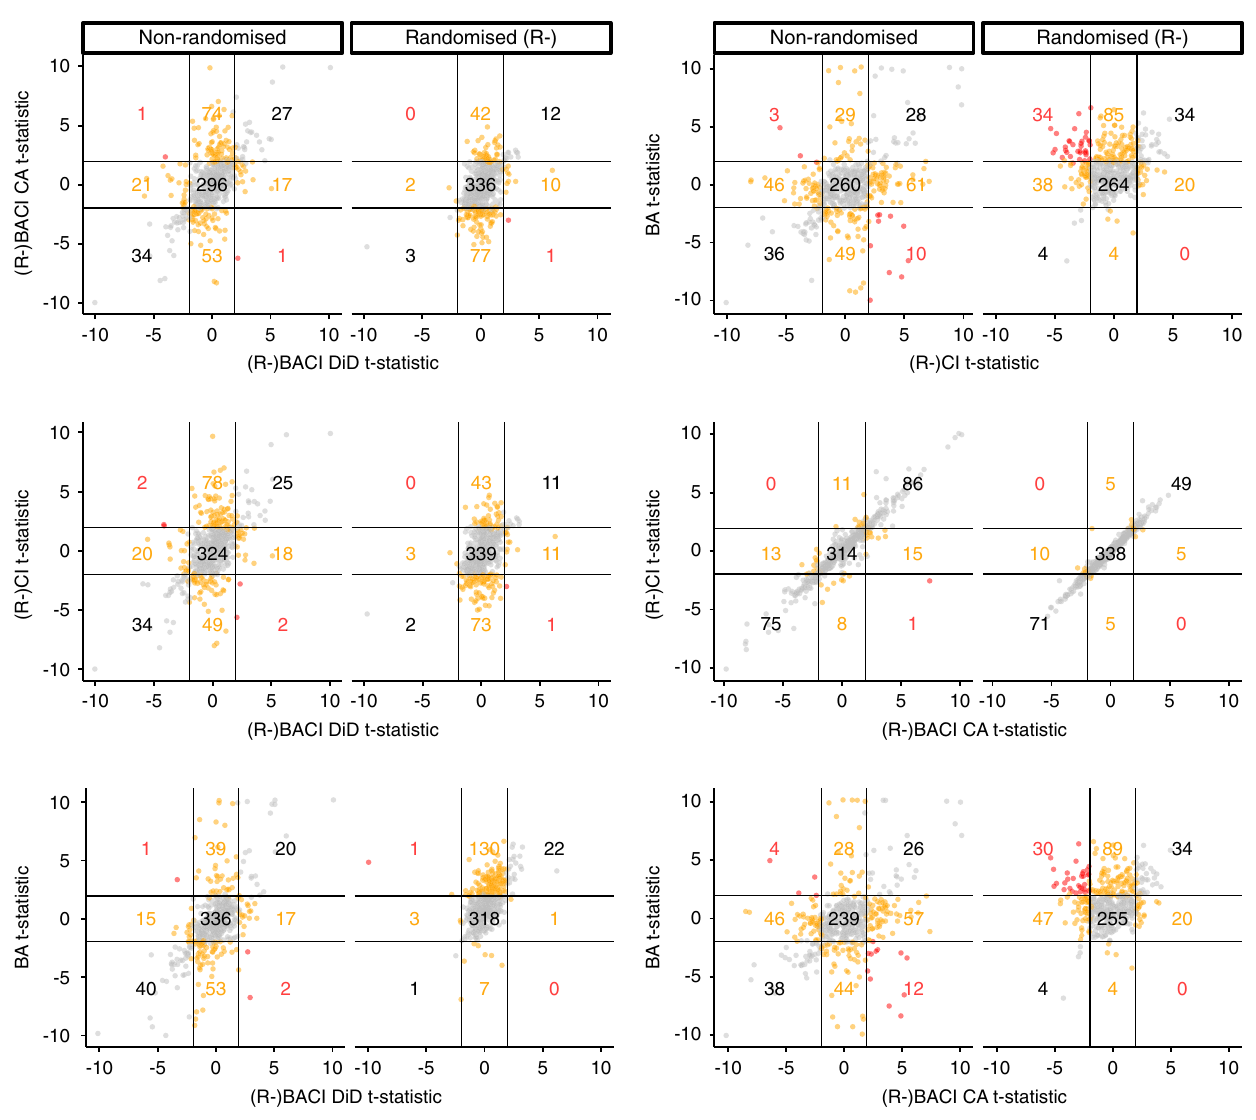
Fig. 3 Pairwise comparisons of t-statistics for estimates obtained using different study designs for responses across 49 different datasets (non- randomised or randomised). t-statistics were obtained from two-sided t-tests of estimates obtained by each design for different responses in each dataset using Generalised Linear Models (see Methods). For randomised datasets, BACI and CI axis labels refer to R-BACI and R-CI designs (denoted by ‘ R- ’ ). DiD Difference in Differences; CA covariance adjustment. Lines at t-statistic values of 1.96 denote boundaries between cells and colours of points indicate differences in direction and statistical signi fi cance ( p < 0.05; grey = same sign and signi fi cance, orange = same sign but difference in signi fi cance, red = different sign and signi fi cance). Numbers refer to the number of responses in each cell. Source data are provided as a Source Data fi le. BA Before-After, CI Control-Impact, BACI